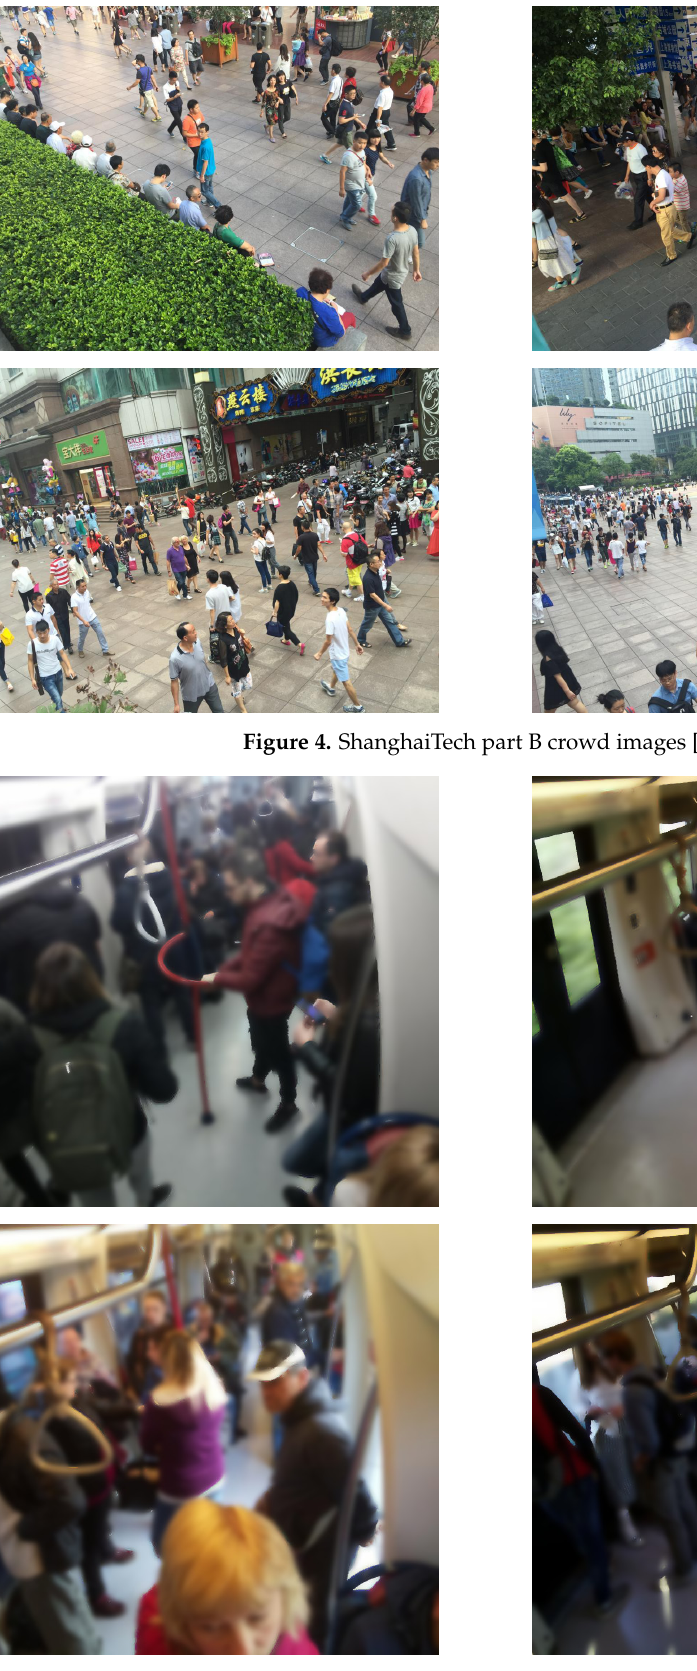
Figure 5. Subway cars passenger-crowd